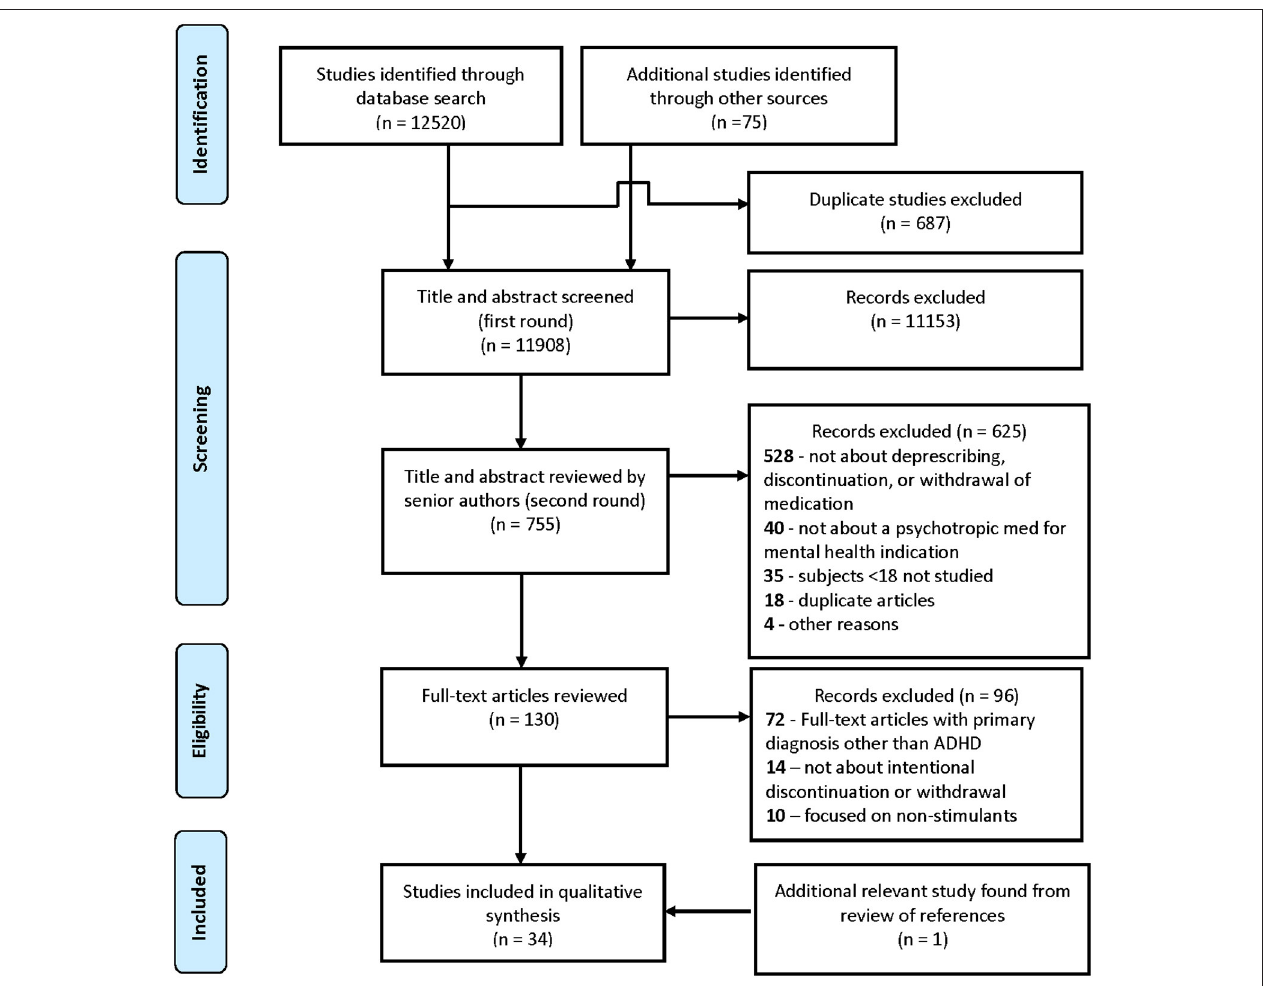
FIGURE 1 | Process identification of studies, screening, and eligibility flow diagram for discontinuation of stimulants in children with ADHD.